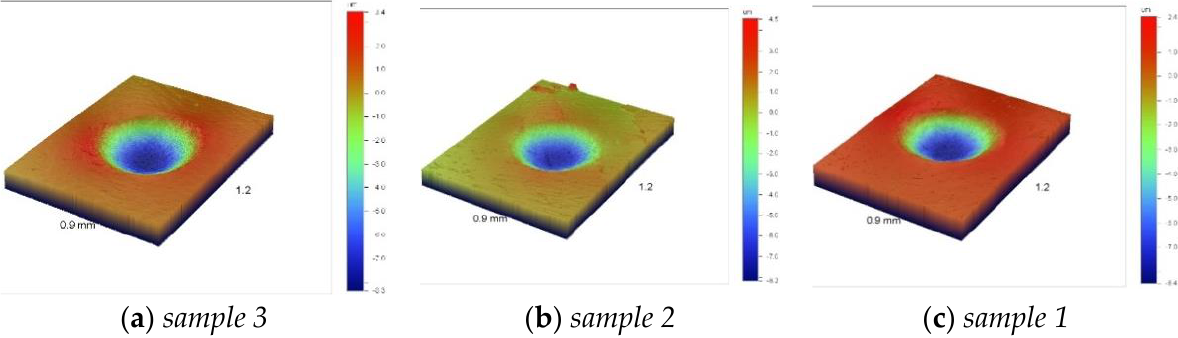
Figure 11. Three-dimensional images of dents on the surface of samples made of low-chromium cast iron, with the test load of 700 N.